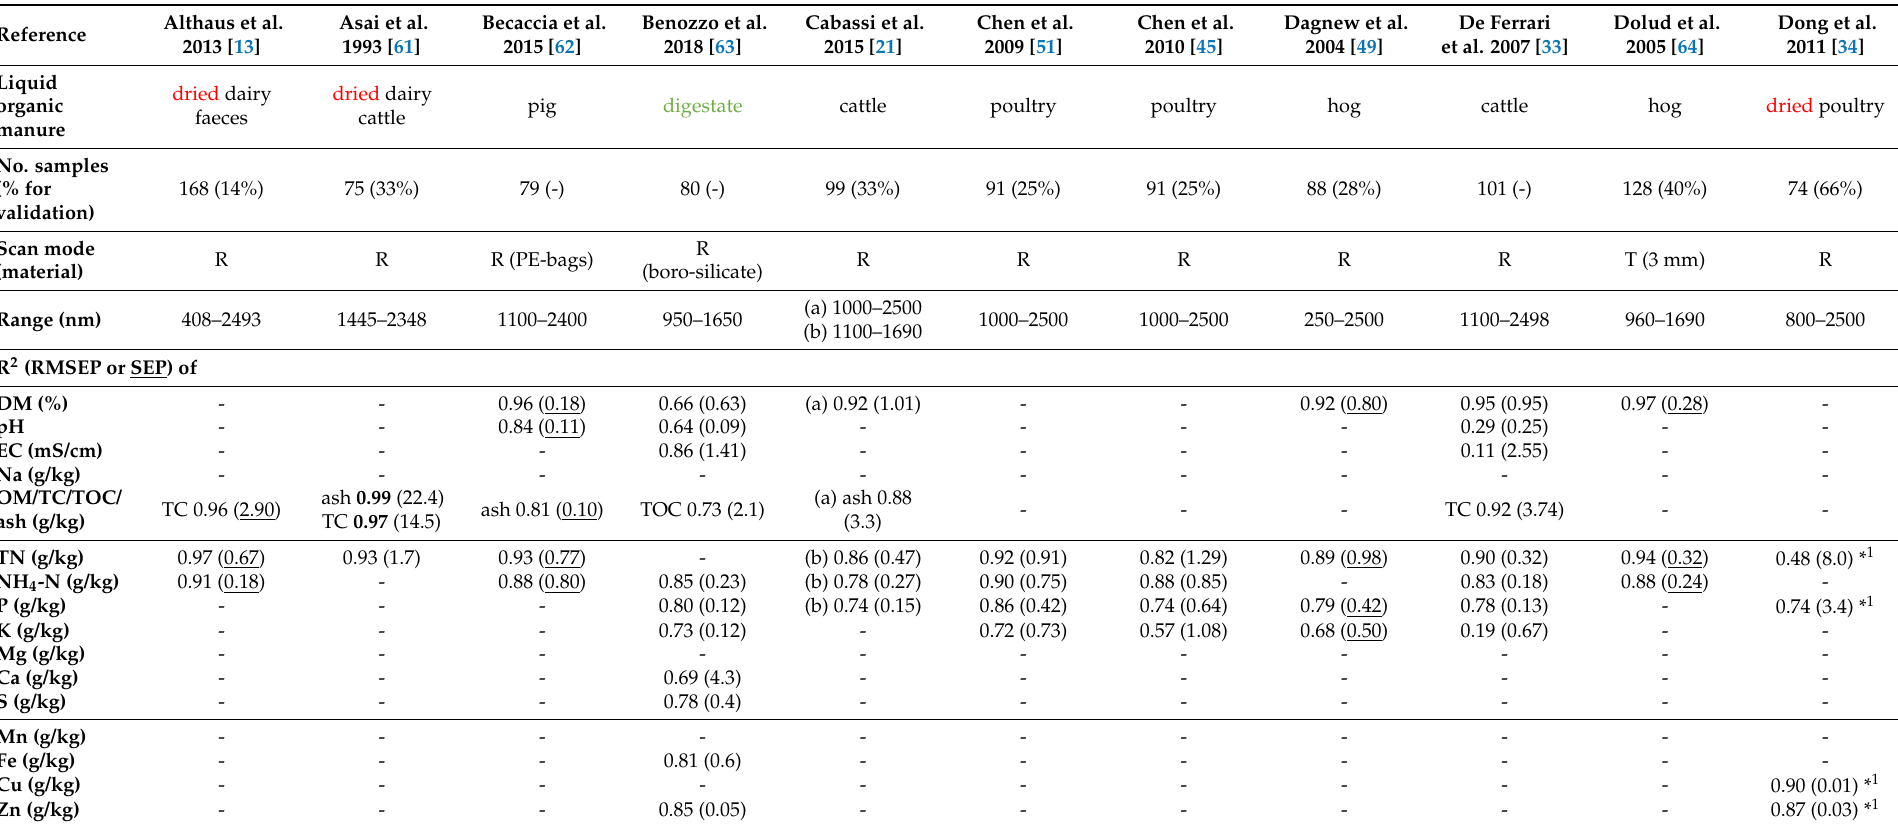
Best values for each parameter are highlighted in bold letters, dried samples in red, digestate samples in green, and SEP values in underlined letters. Scan mode: R = reflectance, T = transflectance; Parameters: DM = dry matter, EC = electrical conductivity, OM = organic matter, TC = total carbon, TOC = total organic carbon, TN= total nitrogen; R 2 = coefficient of determination, RMSEP = root mean squared error of prediction, SEP = standard error of prediction. * 1 On DM